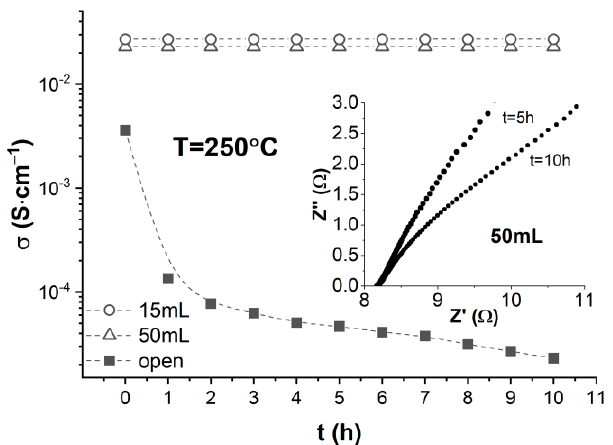
Figure 3. Time dependence of the proton conductivity of CDP measured over a 10 h timespan at T = 250 °C for samples hermetically sealed in 15 mL (circles) and 50 mL (triangles) of dry air, and in an open atmosphere (filled squares). The inset shows that high-frequency segments of Nyquist plots collected at 5 h and 10 h after the onset of the superprotonic conduction in CDP sealed in the 50 mL chamber intersect the real (in-phase) impedance axis at the same value Z′ = 8.16 Ω.